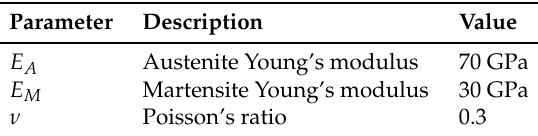
Table 2. Nitinol mechanical